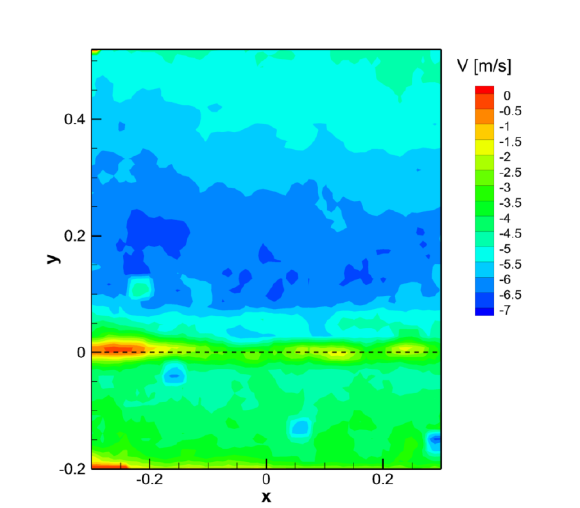
Fig. 11. Mean vertical velocity component distribution. Re = 1M.